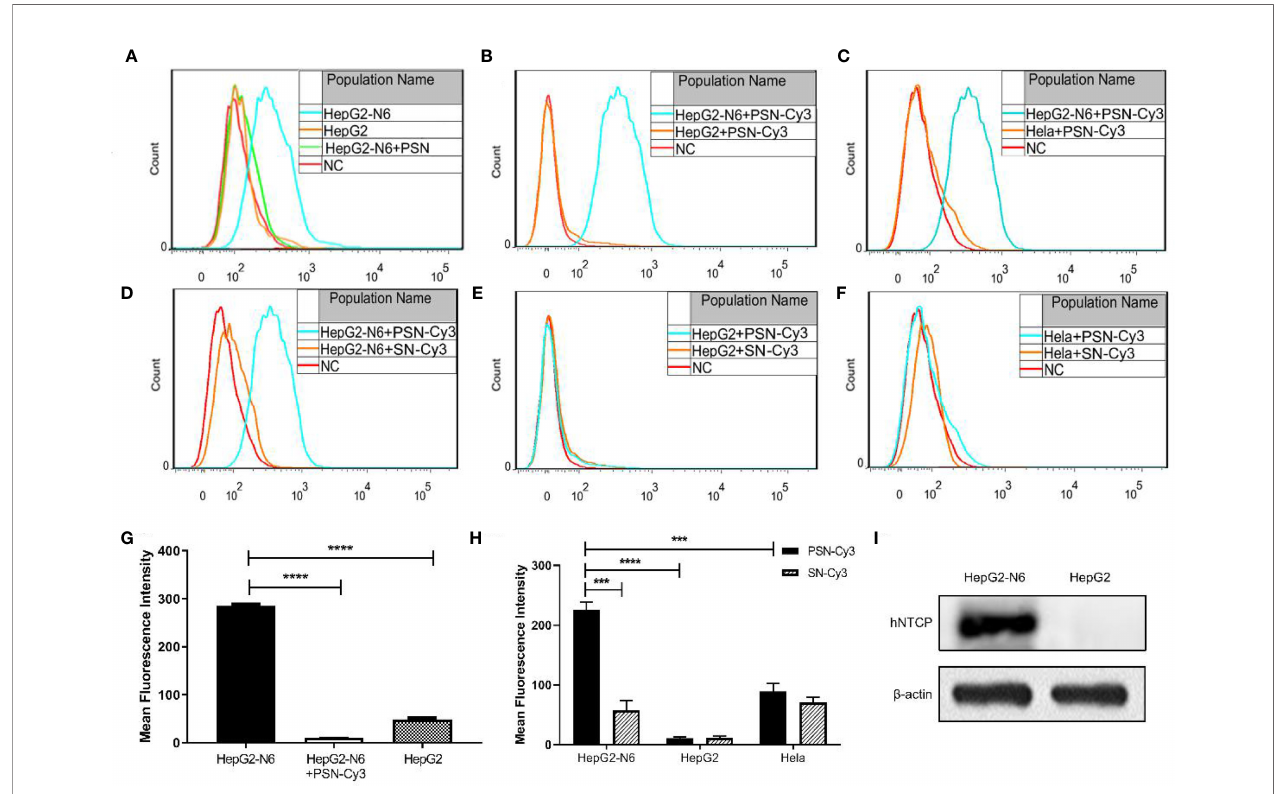
FIGURE 6 | Targeting detection of liposomal nanoparticles. (A) After NTCP-FITC antibody labeling, fl ow cytometry detects NTCP receptor expression on cells and PSN competition for receptor binding, NC is the same amount of cells stained with FITC-labeled isotype control antibody; (B – F) Flow cytometric detection of the targeting properties of siRNA-Cy3 loaded nanoparticles PSN and SN to HepG2-N6, HepG2 and Hela cells, NC is the corresponding cell added with the same amount of PBS; (G) Comparison of the fl uorescence intensity of each treatment group in Figure A ; (H) Comparison of fl uorescence intensity of each experimental group in Figure B – F ; (I) Western blot analysis of NTCP expression in HepG2-N6 and HepG2 cells. Data are represented as the mean ± SD from at least three independent experiments. *** P < 0.001, **** P <